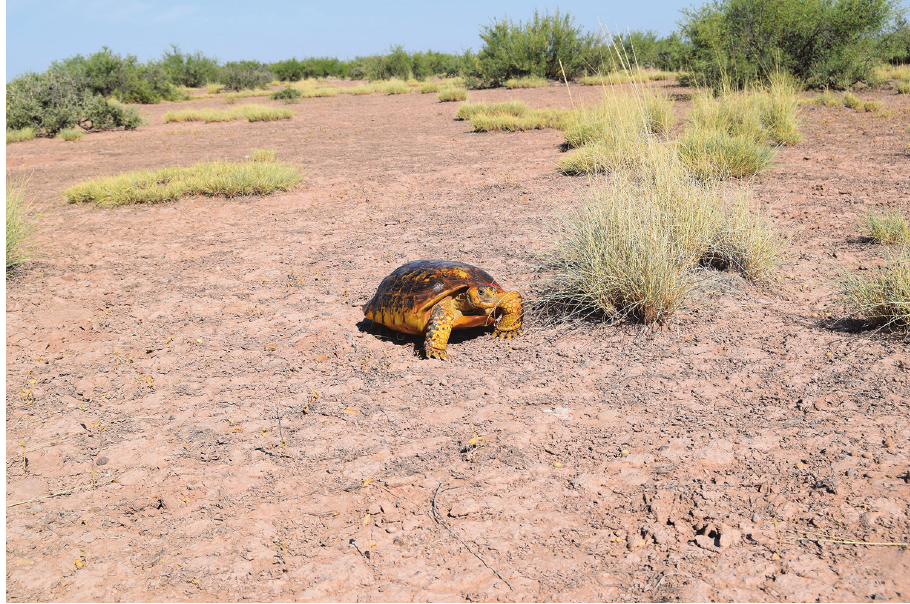
Figure 1. Gopherus flavomarginatus and halophytic grassland Hilaria mutica